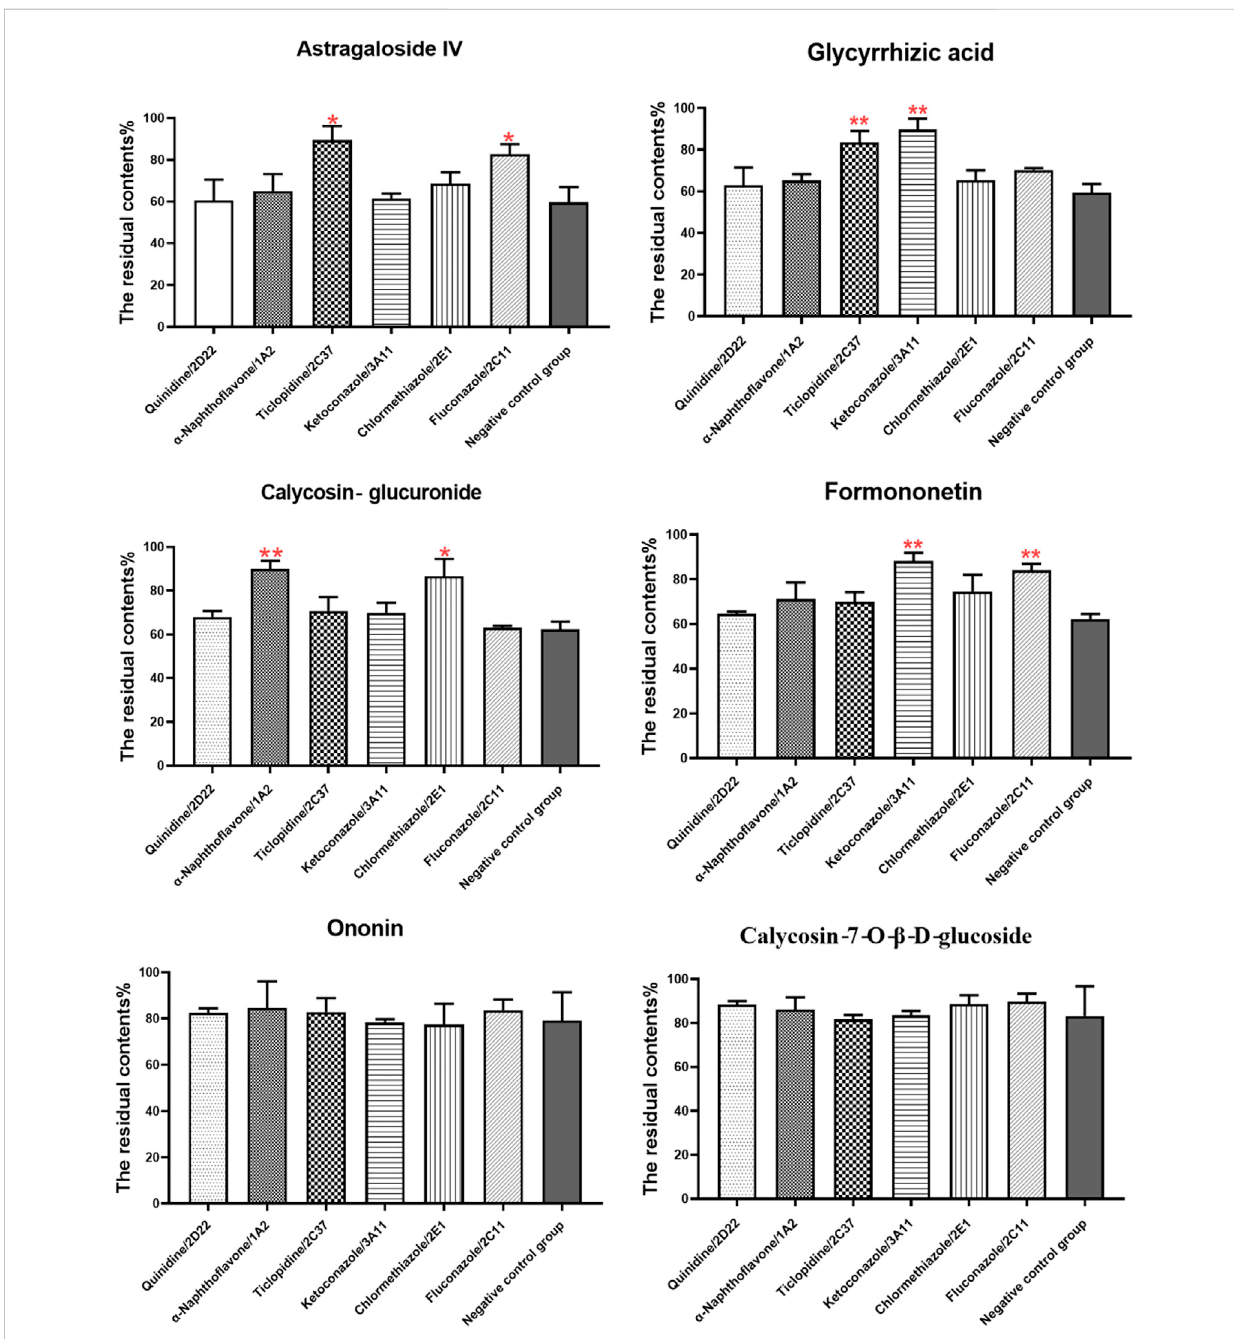
FIGURE 4 Effects of speci fi c CYP enzyme inhibitors on the metabolism of the six components.